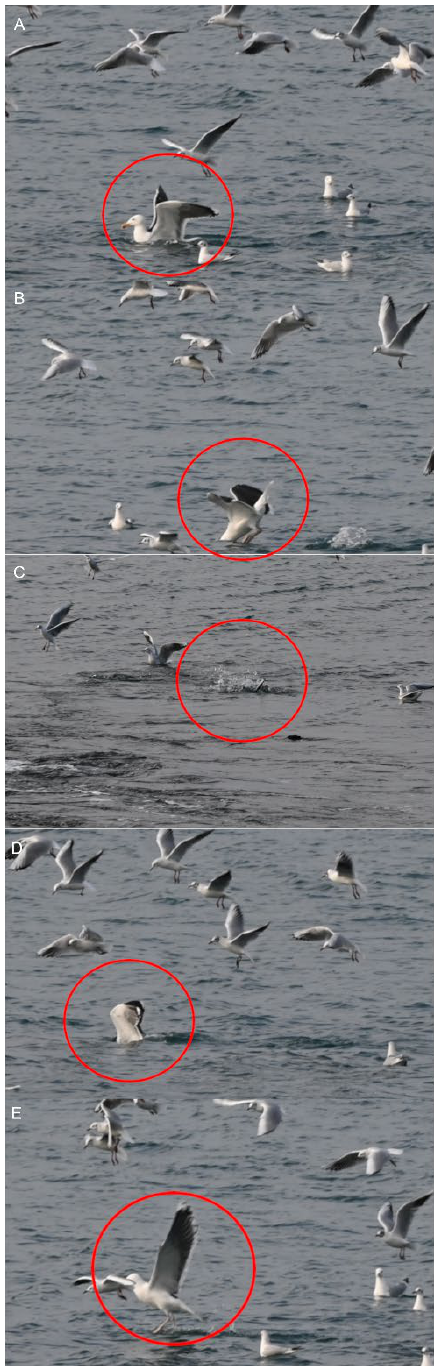
Figure 5. Motor sequence of Larus marinus (red circle) preying on the same fish shoal as Chroi- ( C , D ) The bird plunges to catch the fish. The bird moves out of water ( E )Time between two frames: 0.01